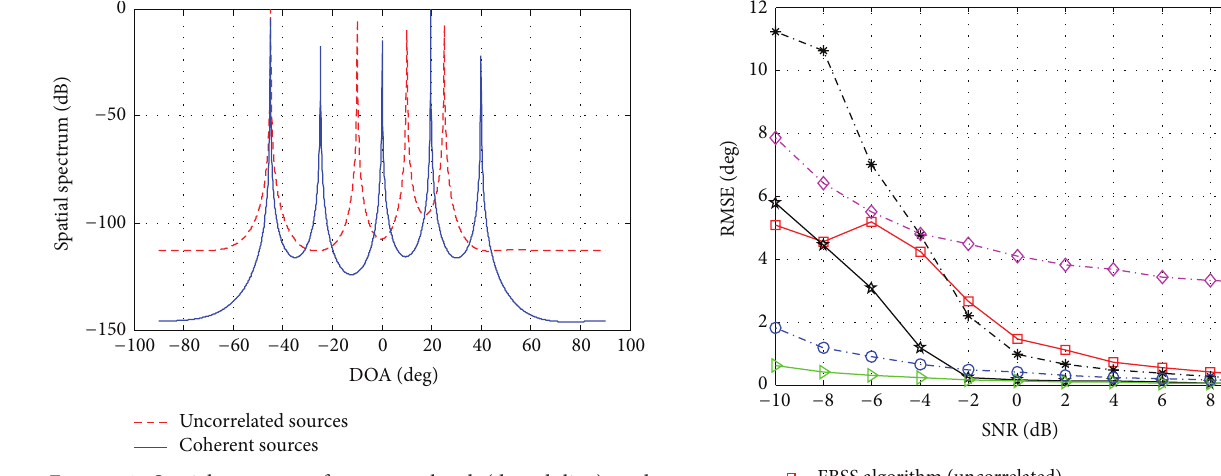
Figure 1: Spatial spectrum for uncorrelated (dotted line) and coherent (solid line) signals.